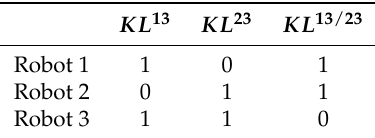
Table 7. The proposed signature matrix of robot